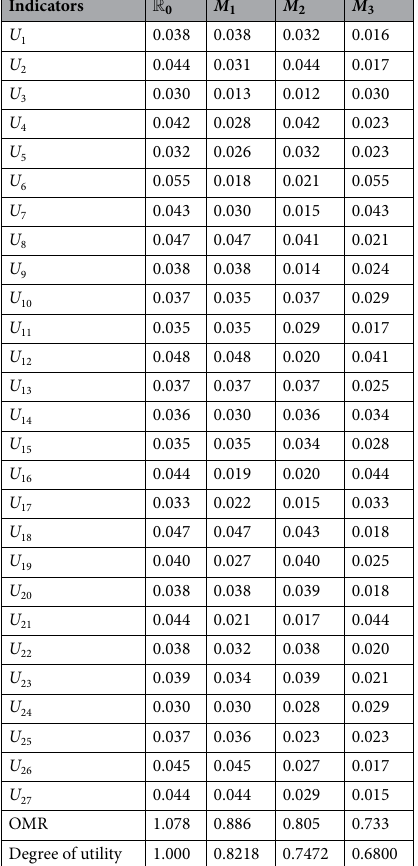
Table 13. The Score value, OPR and UD for SIBOs assessment.